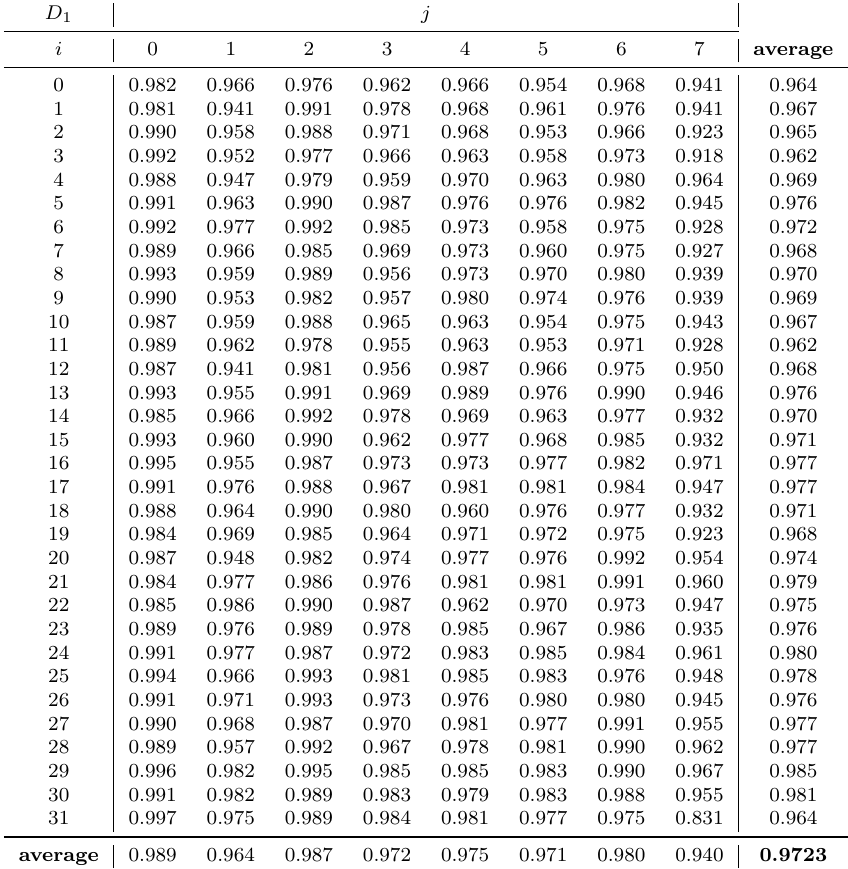
Table 20: Empirical probability to recover the message bit m [8 i + j ] from a single trace using both points. Average results for 1K traces from device D 3